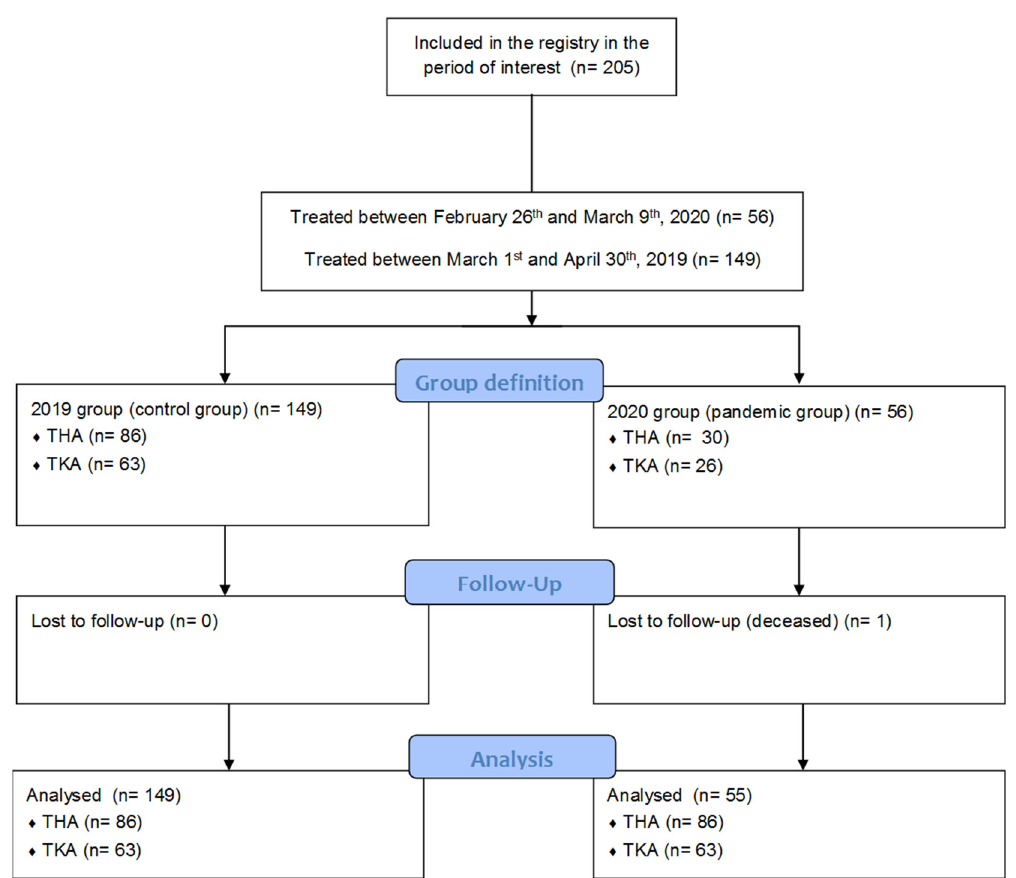
Figure 1. Diagram of patients’ inclusion and follow-up during the study. THA: total hip arthroplasty; TKA: total knee arthroplasty.